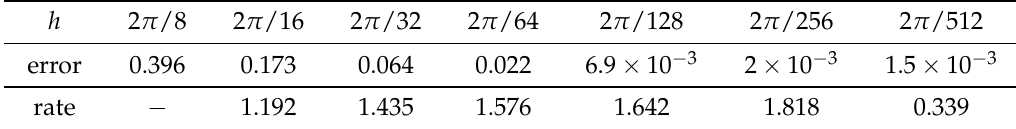
Table 2. Computational error in u h of (21) for α = 0.7 with respect to the L 2 ( Ω ) -norm with the experimental convergence rates.